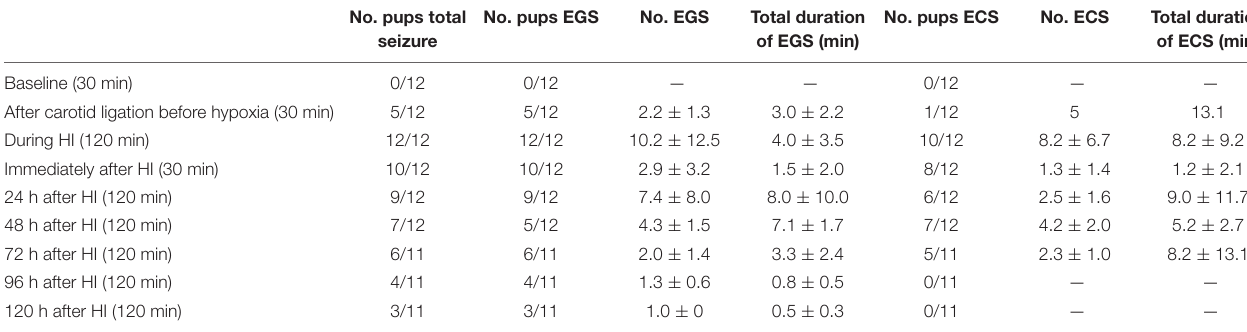
TABLE 1 | Effects of hypoxia-ischemia on seizures in neonatal rats.